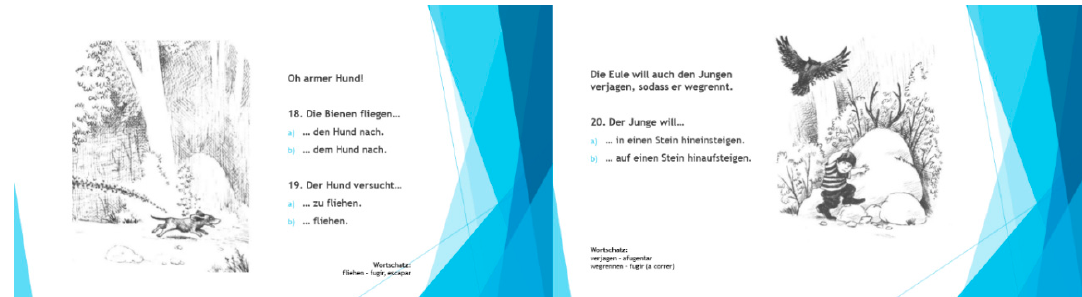
Figure A34. Posttest: Binary-choice recognition task.